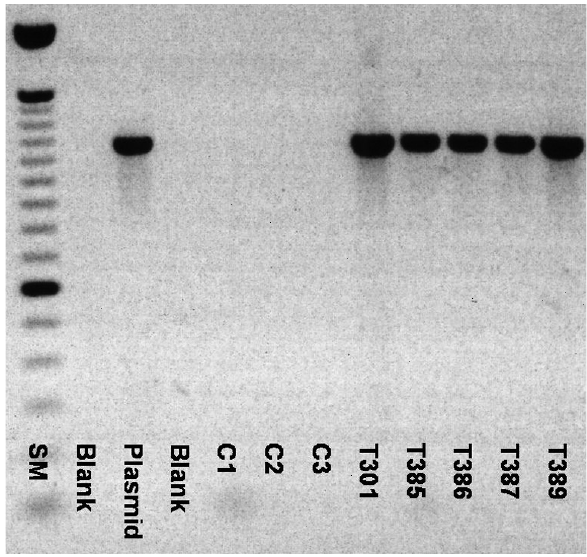
Figure 3 - Detection of ech42 mRNA transcripts by RT-PCR. SM (size marker) – 100 bp DNA ladder, Blank – H 2 O sample, C1 – non-transgenic Pinova, C2 and C3 – non-transgenic plants of two other apple cultivars, T301-T389 – Nag+Endo transgenic lines of the apple cultivar